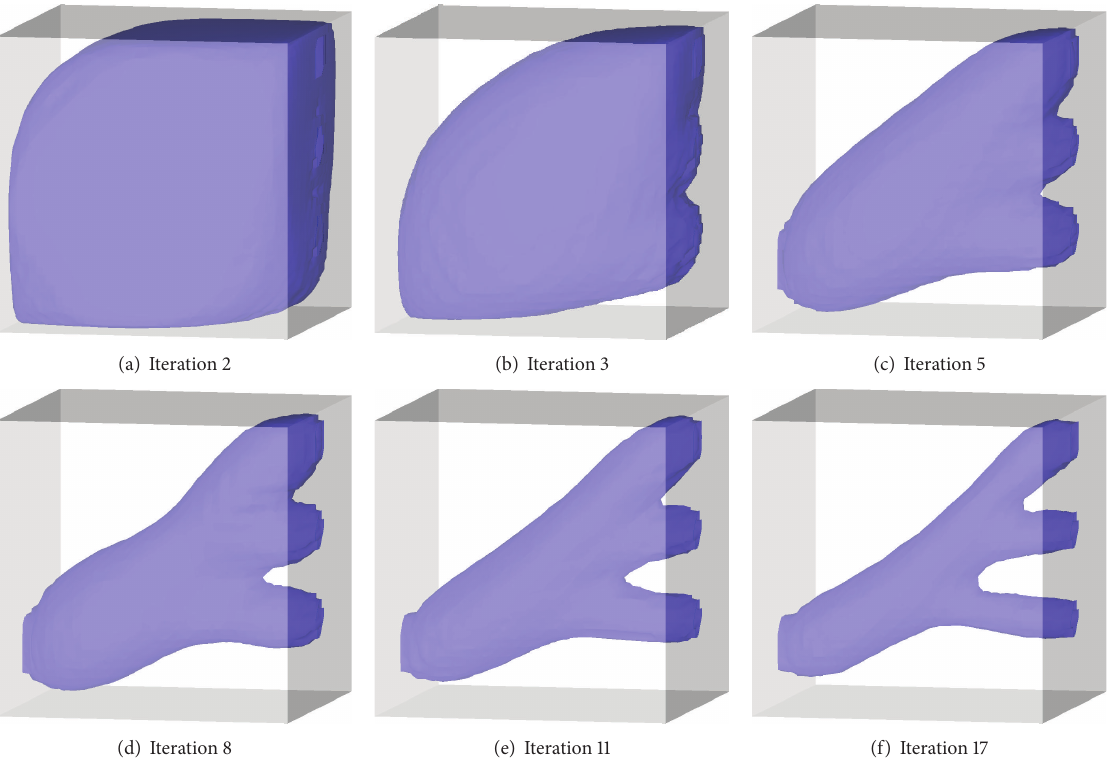
Figure 7: The obtained geometries during the optimization